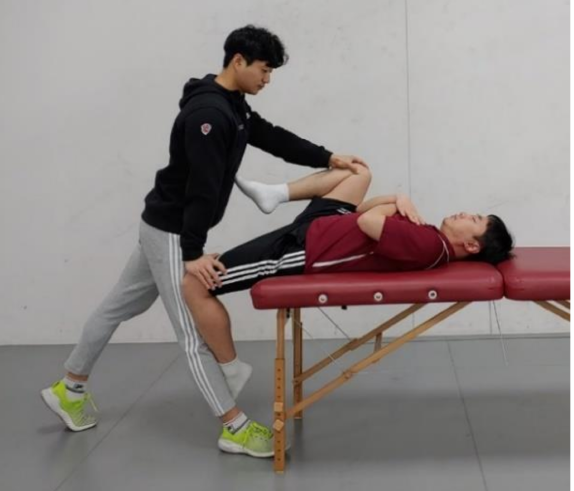
Figure 2. A subject performing stretch using the modified Thomas test. The researcher gradually provided an additional tensional force until the patient felt a self-selected moderate discomfort, then held the position for 30 s. The left hip flexors and right knee extensors are being